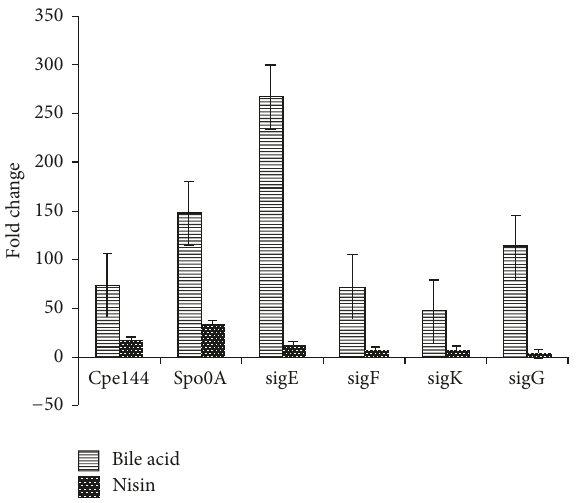
Figure 3: Representative results of the fold change in the transcrip- tion of sporulation-related genes from C. perfringens SM101 grown in BHI in the presence of bile acids (lined bars) or nisin (dotted bars) after 3.5 h of incubation in comparison with transcription of these genes in bacteria grown in BHI alone. Samples taken at 2 and 5 h also showed upregulation of the same genes.